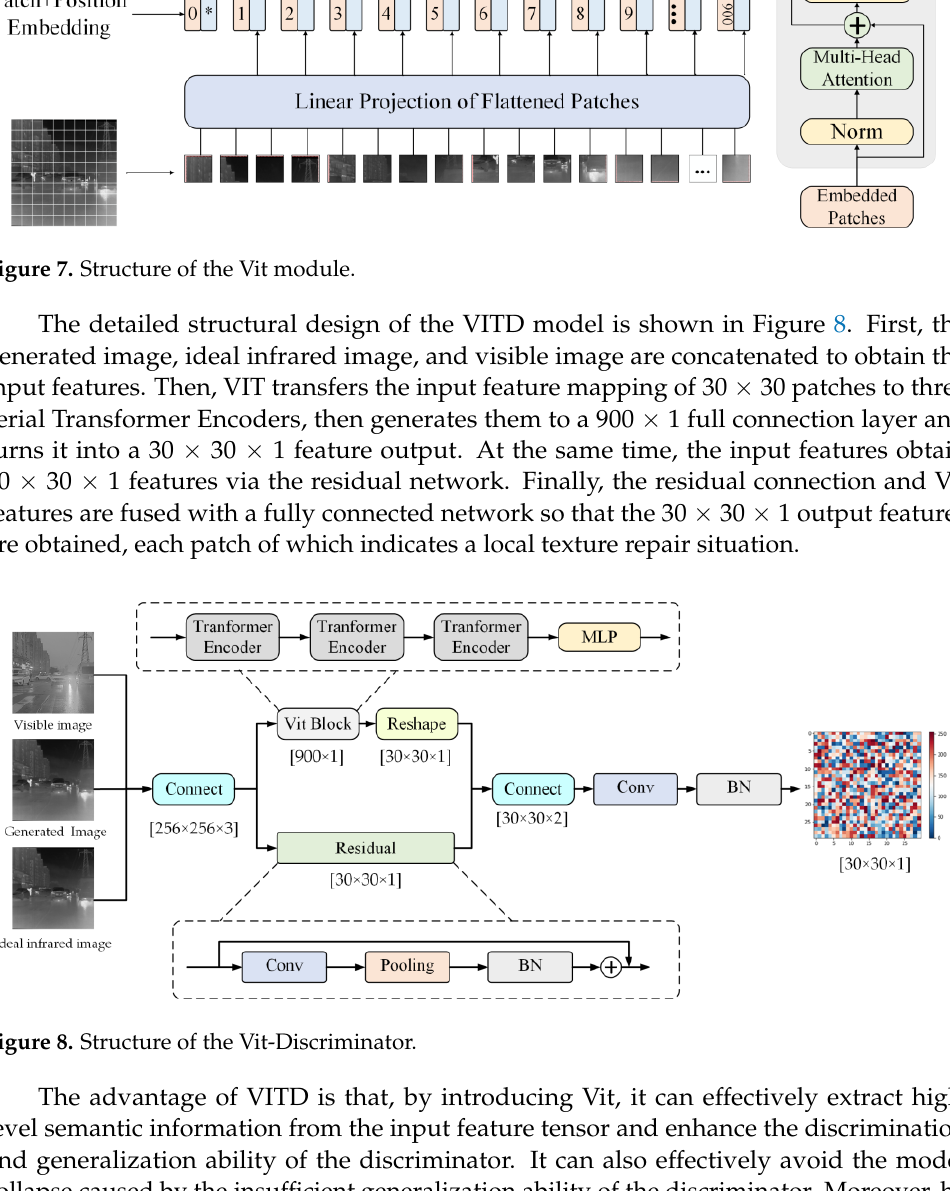
Figure 7. Structure of the Vit module.